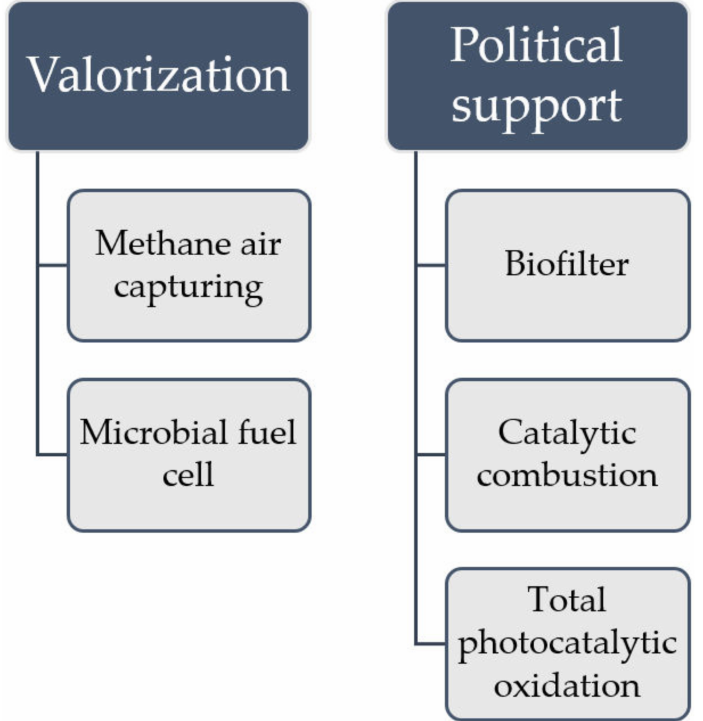
Figure 8. Potential post-emission methane reduction technologies sorted after the two main economic strategies valorization and direct payments, e.g., from a negative carbon